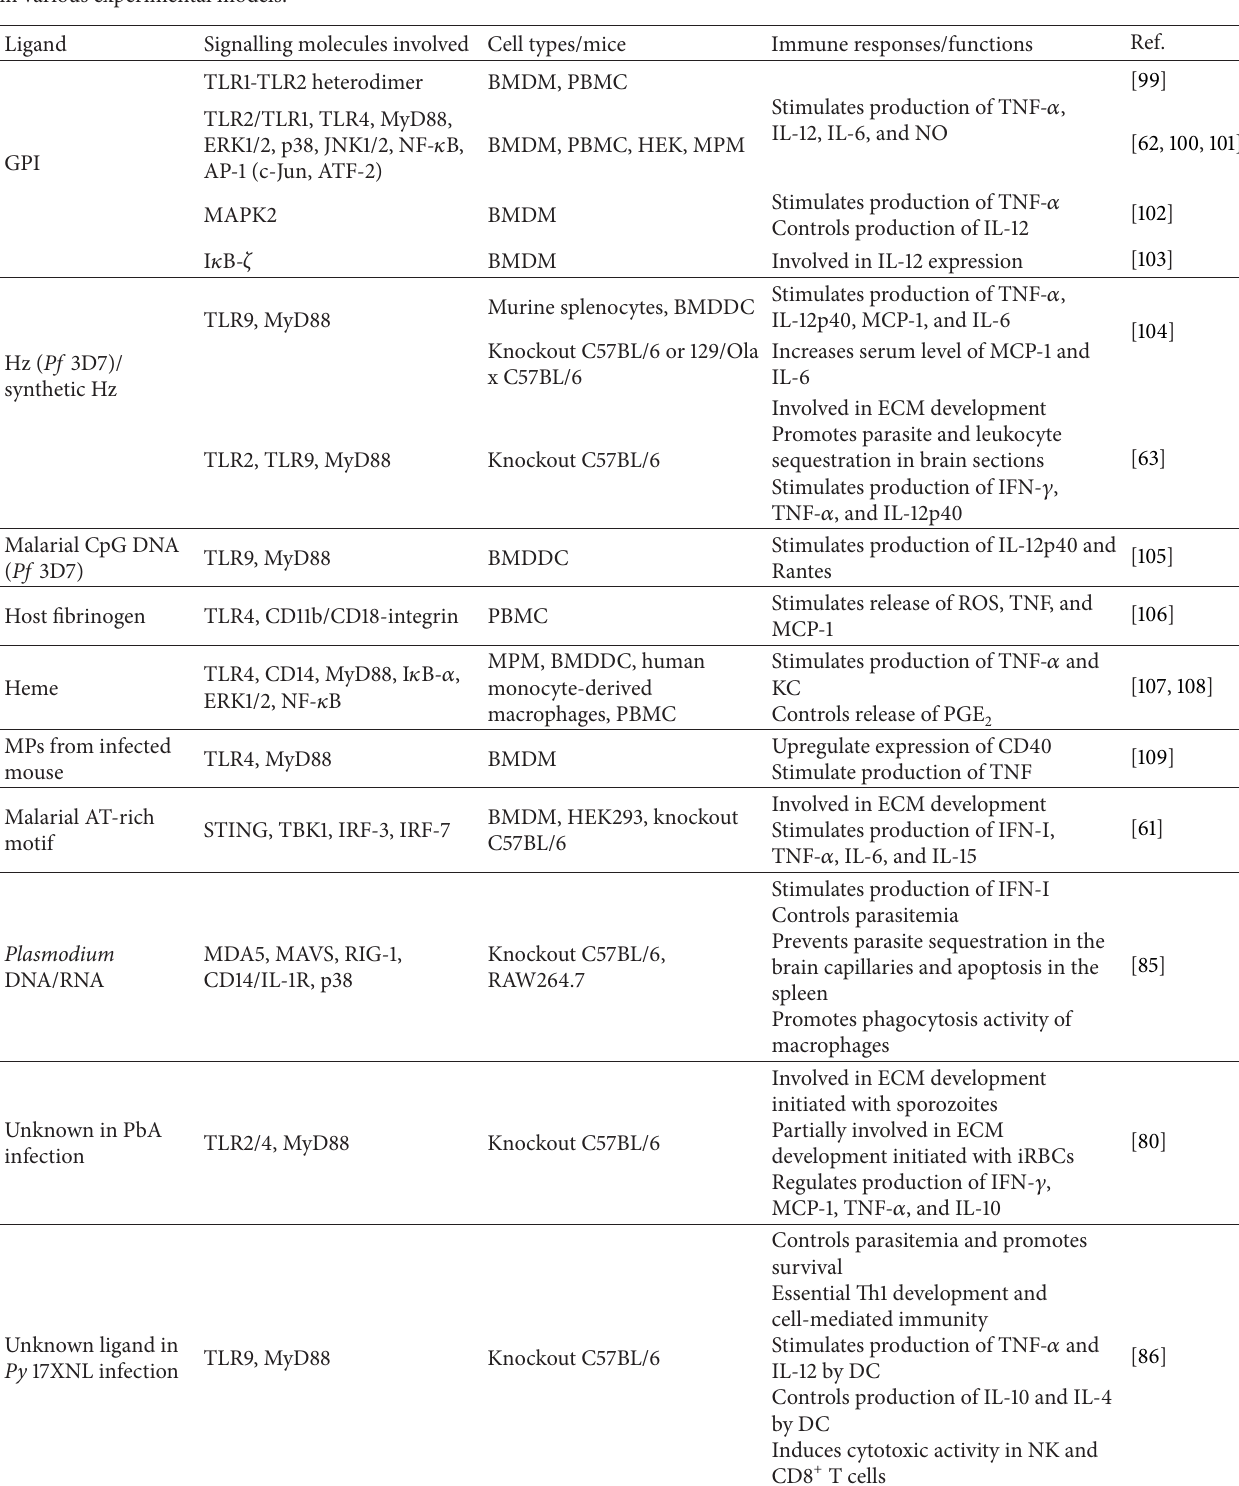
Table 2: List of malarial ligands that stimulate different signaling molecules to trigger diverse immune responses and affect disease outcome in various experimental